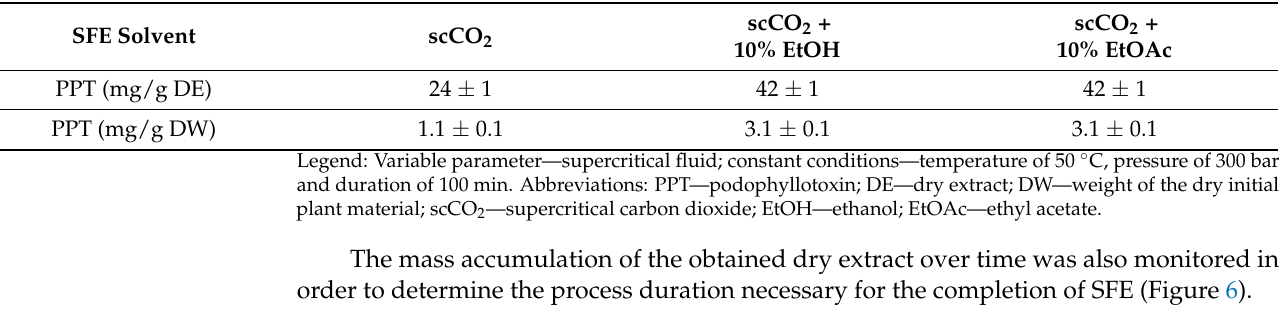
Table 4. Effect of the solvent on the PPT recovery by supercritical fluid extraction of J. virginiana leaves.